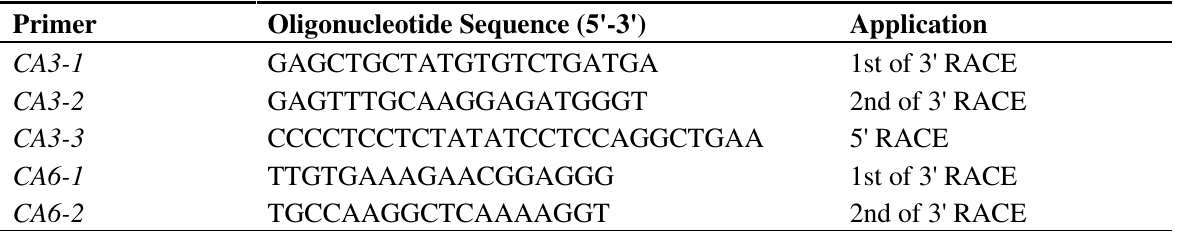
Table 4. Primers used for genes isolation and expression